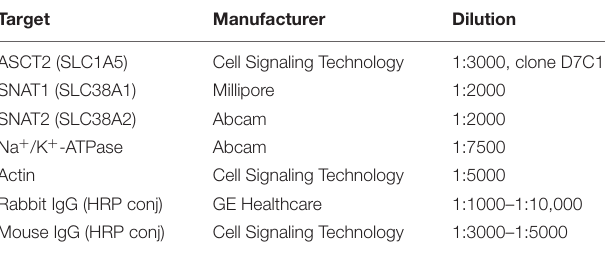
TABLE 2 | Source of antibodies and dilution for western